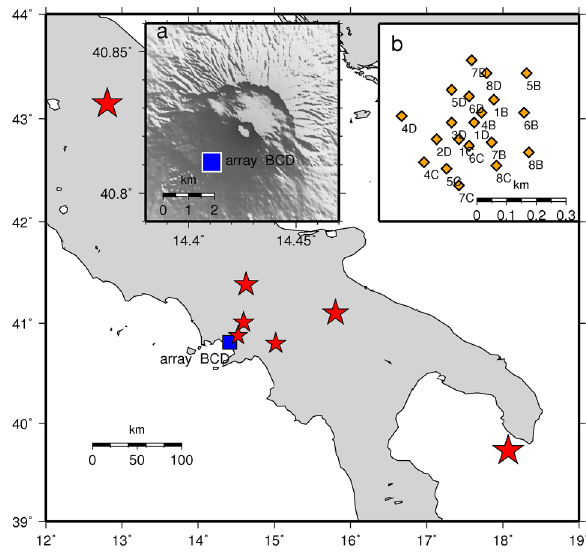
Figure 1. Map of southern Italy showing the position of Mt. Vesu- vius (blue square) and earthquake epicenters (red star). The two in- sets show the topography of Mt. Vesuvius with the array location (a) and the array configuration (b).